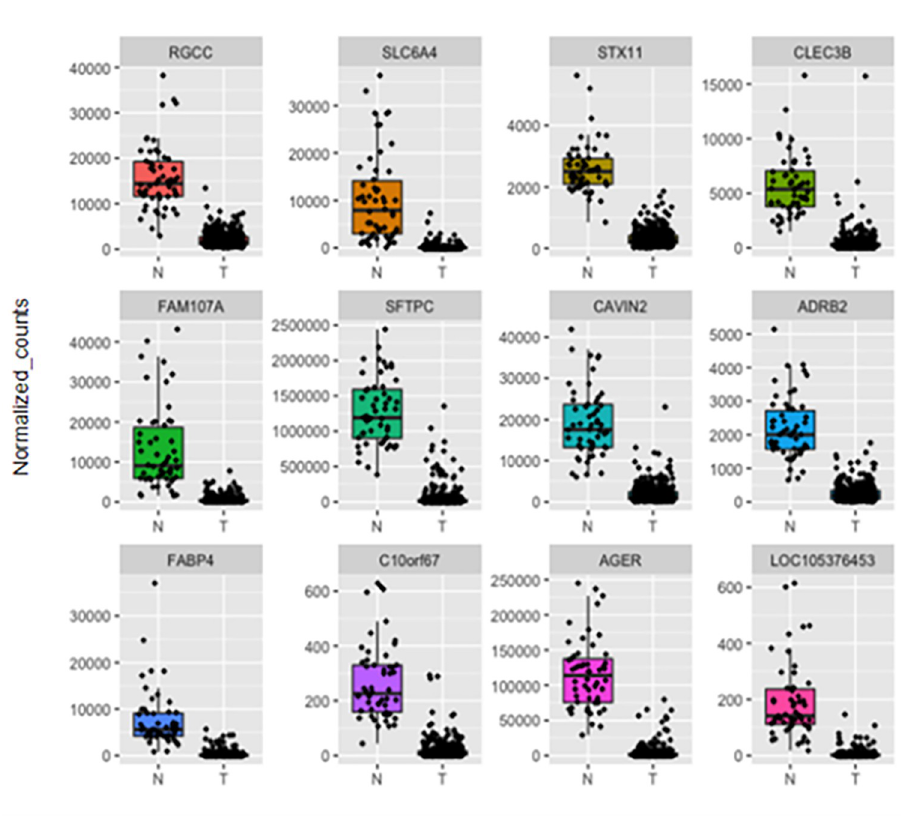
Fig 11. Boxplots representing the expression level of the RFE-MI common genes in LUAD patients in comparison to normal samples. N represents normal tissues and T represents tumor tissues.